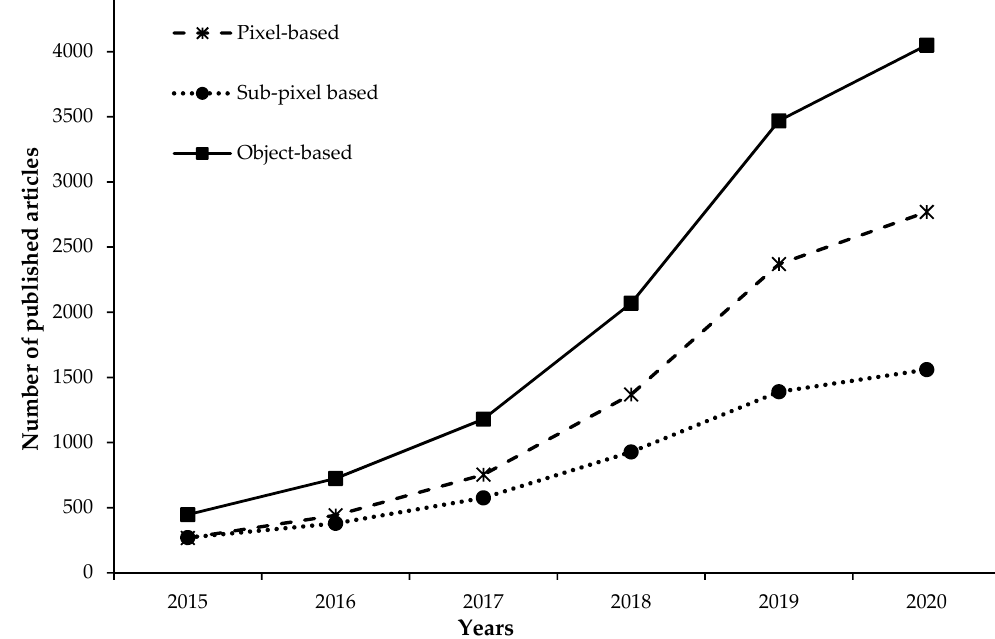
Figure 5. The accumulative number of published articles in Google Scholar which mentioned pixel ‐ based, sub ‐ pixel and object ‐ based. Search terms used included ”Sentinel ‐ 2” AND “sub ‐ pixel”, “Sentinel ‐ 2” AND “pixel ‐ based” and “Sentinel ‐ 2” AND “object ‐ based”.